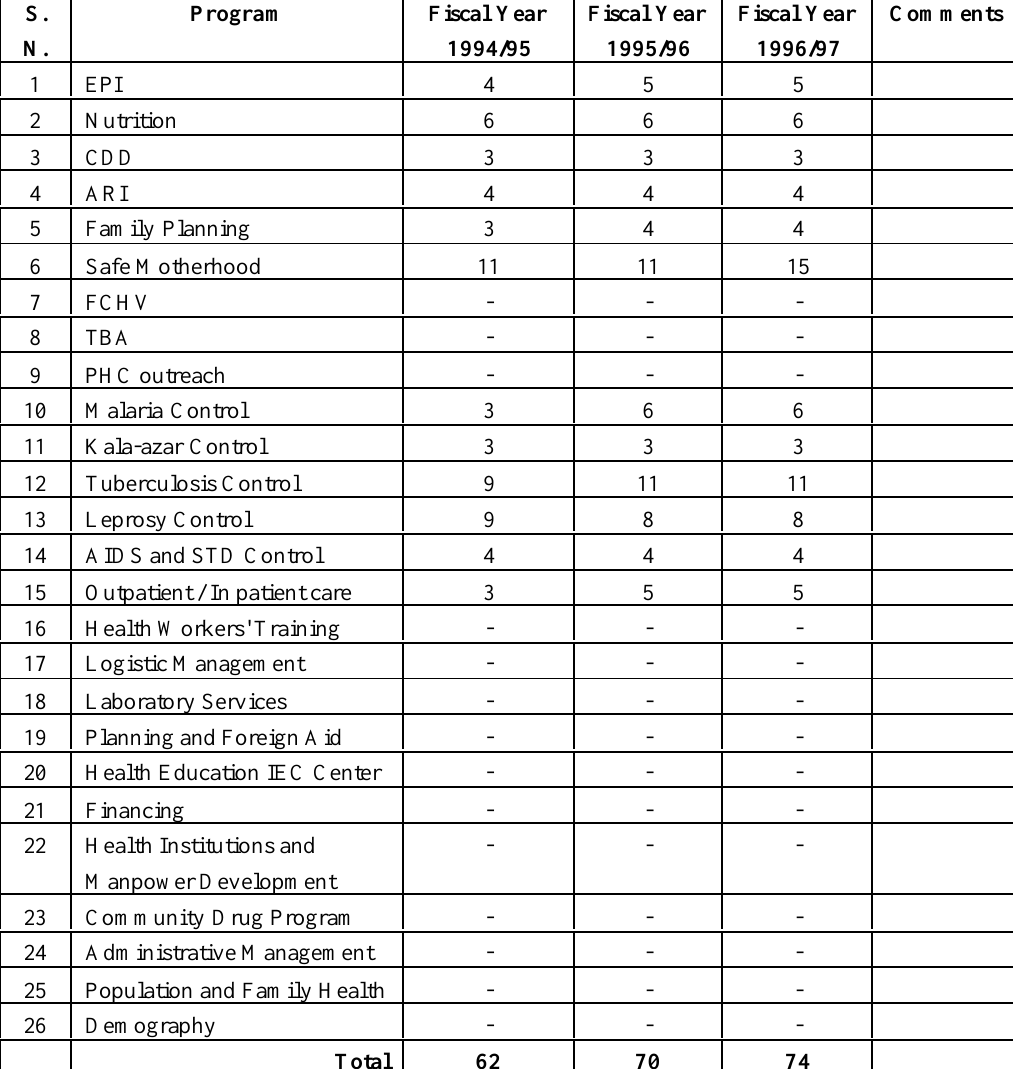
Table 2: Number of Indicators mentioned in the AR by various programs by years. S. N.